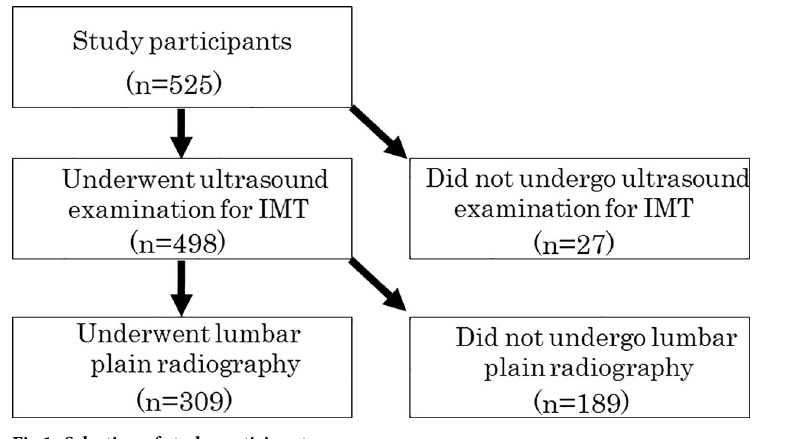
Fig 1. Selection of study